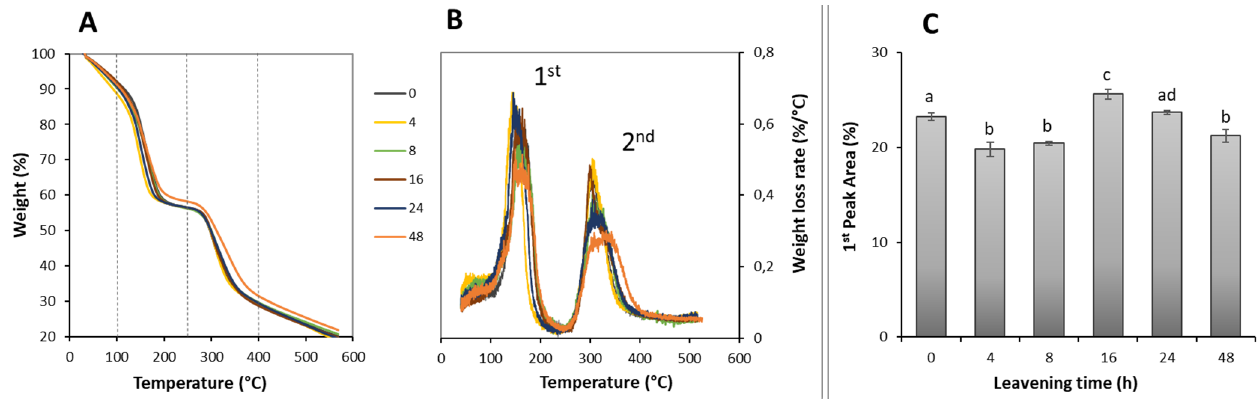
Figure 3. Thermogravimetric analysis (TGA) of pizza dough at increasing leavening times. ( A ) TGA curves as functions of temperature. ( B ) first derivate of TGA curves. ( C ) First peak area from the derivate curves. Different letters indicate samples significance calculated by an ANOVA statistical test with Post Hoc Tukey ( p < 0.05).